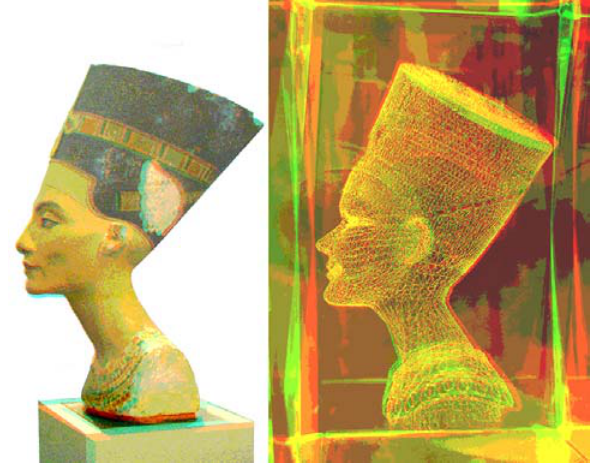
Figure 7. Detailed color anaglyphs of the famous bust of Nofretete from Tell el-Amarna (Egypt) (nowadays in Berlin, Germany) in comparison with an “early bird” lasered crystal, lacking resolution and radiometric